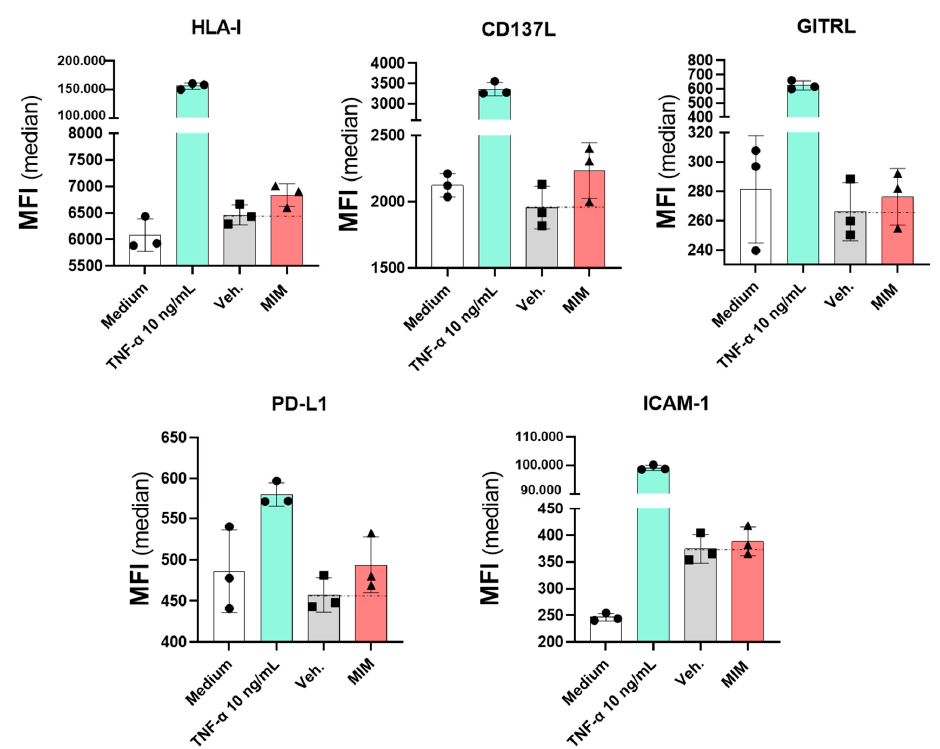
Figure 5. MIM modulates the expression of immunity-related endothelial cell surface markers. MIM modulates the expression levels, expressed as MFI, of several endothelial cell surface markers (HLA-I, CD137L, GITRL, PD-L1 and ICAM-1). HUVECs were incubated for 48 h in presence of either MIM or vehicle (Veh.) at 11 mM. TNF- α at 10 ng/mL was used as a positive control. The results represent the mean ± SD of one technical triplicate for each condition.